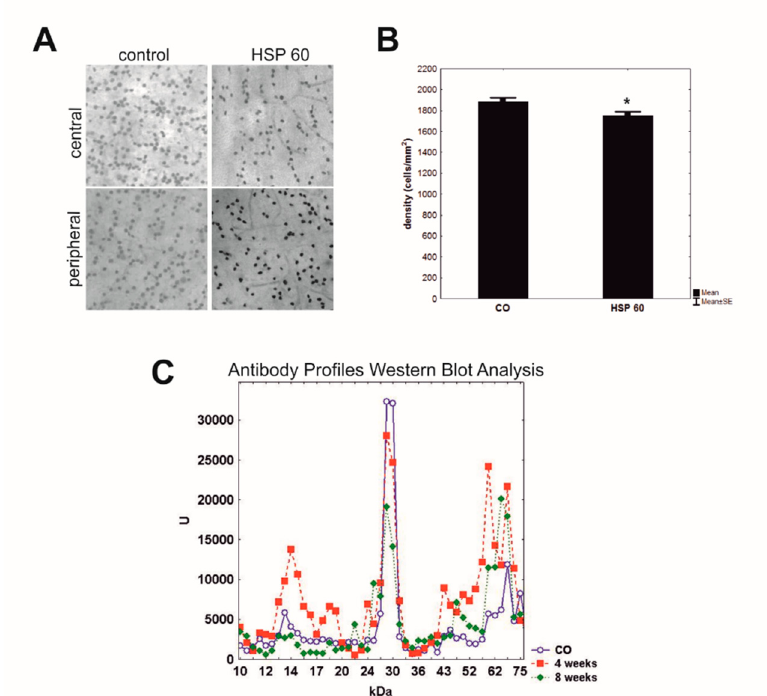
Figure 3. ( A ) Retinal ganglion cells were labeled by Brn3a in retinal flatmounts of rats immunized with HSP60 and controls. The central and peripheral part of retina (40x magnification) were analyzed. ( B ) After eight weeks, rats immunized with HSP60 showed a significant loss of retinal ganglion cells in comparison to control animals (CO; * p = 0.02). Values are mean ± SEM. ( C ) Mean antigen-antibody reactivity of the serum of the HSP60 group at four and eight weeks and control group (CO) was plotted against the corresponding molecular weight of the retinal antigen. Complex antibody regulations could be detected four and eight weeks after immunization with HSP60. These changes altered according to the time after immunization. [50].